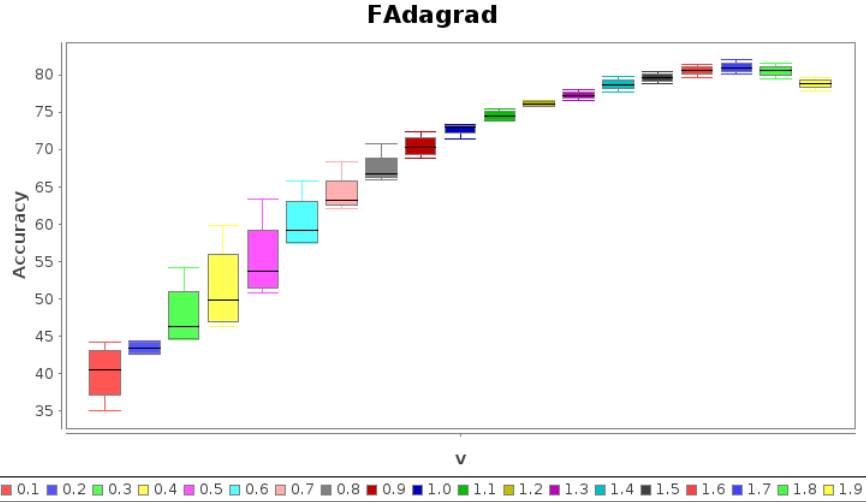
Figure 13. Experiment 3.1: FAdagrad cross-folding accuracies, K = 4 folds, ν ∈ [ 0.1,1.9 ]